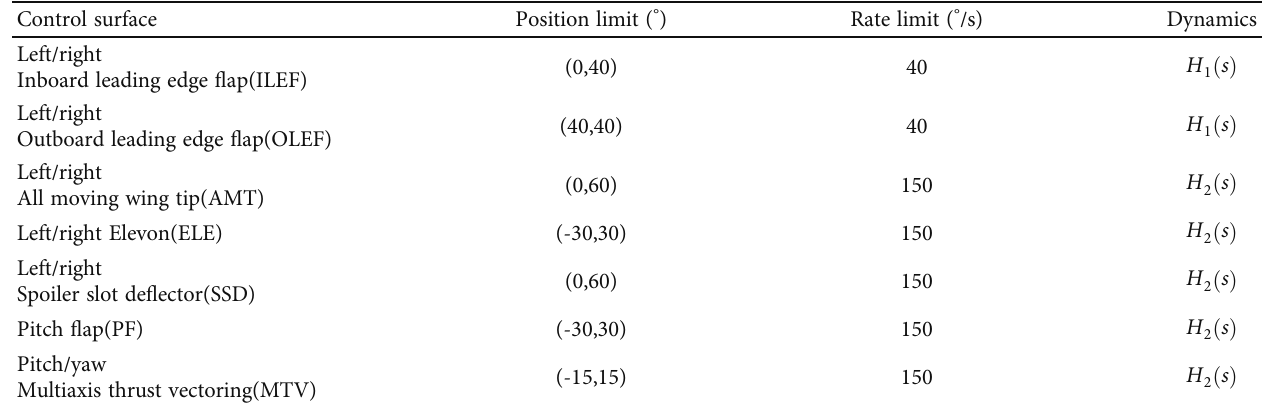
Table 2: ICE aircraft control surfaces